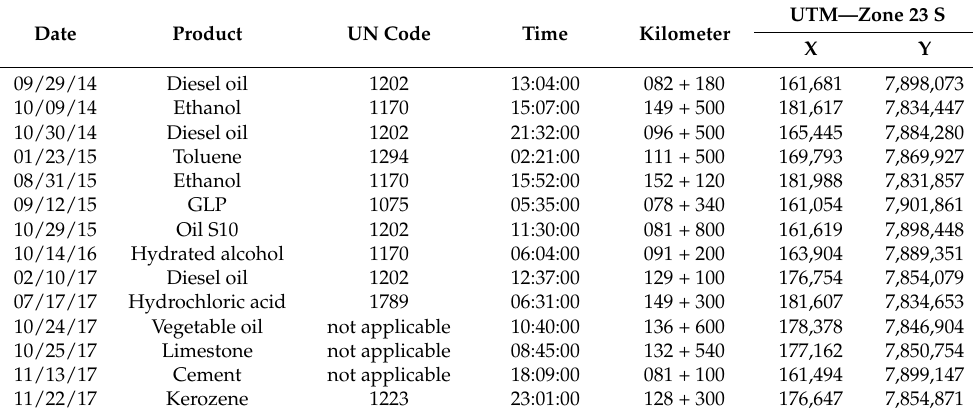
Table 2. Occurrences involving dangerous products in BR 050 during the monitored period. Symbols: UN—United Nations; UTM—Universal Transverse Mercator (coordinate system); X, Y—planimetric coordinates of the